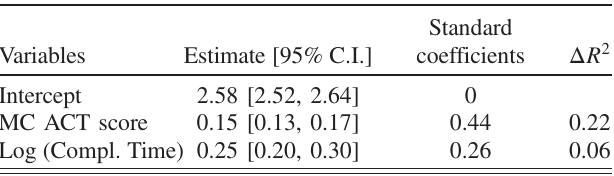
TABLE V. Results of a model predicting the course grade, ranging from 0 – 4, with the student ’ s (mean-centered) ACT score and the log of their average completion time as the independent variables. The estimates of the coefficients are presented with 95% confidence intervals. The Δ R 2 column corresponds to the increase in R 2 as the model was forward